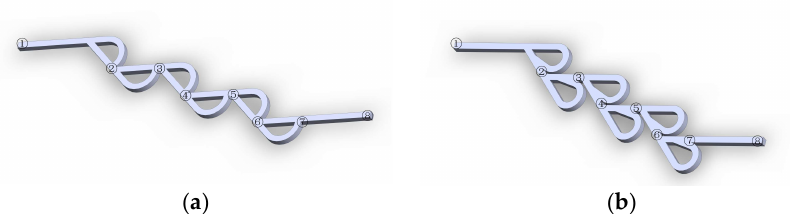
Figure 1. Schematic diagram of size and structure of two Tesla valves (mm) (( a ) T45-R, ( b ) GMF, and the width of entrance is 100 mm).